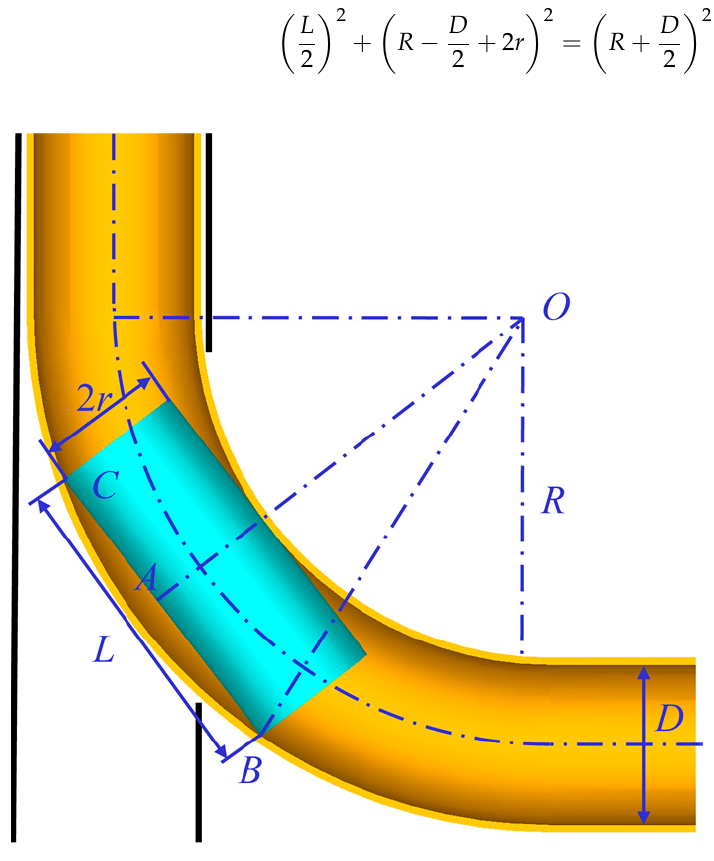
Figure 14. The dimensional relationship of the flexible joint.